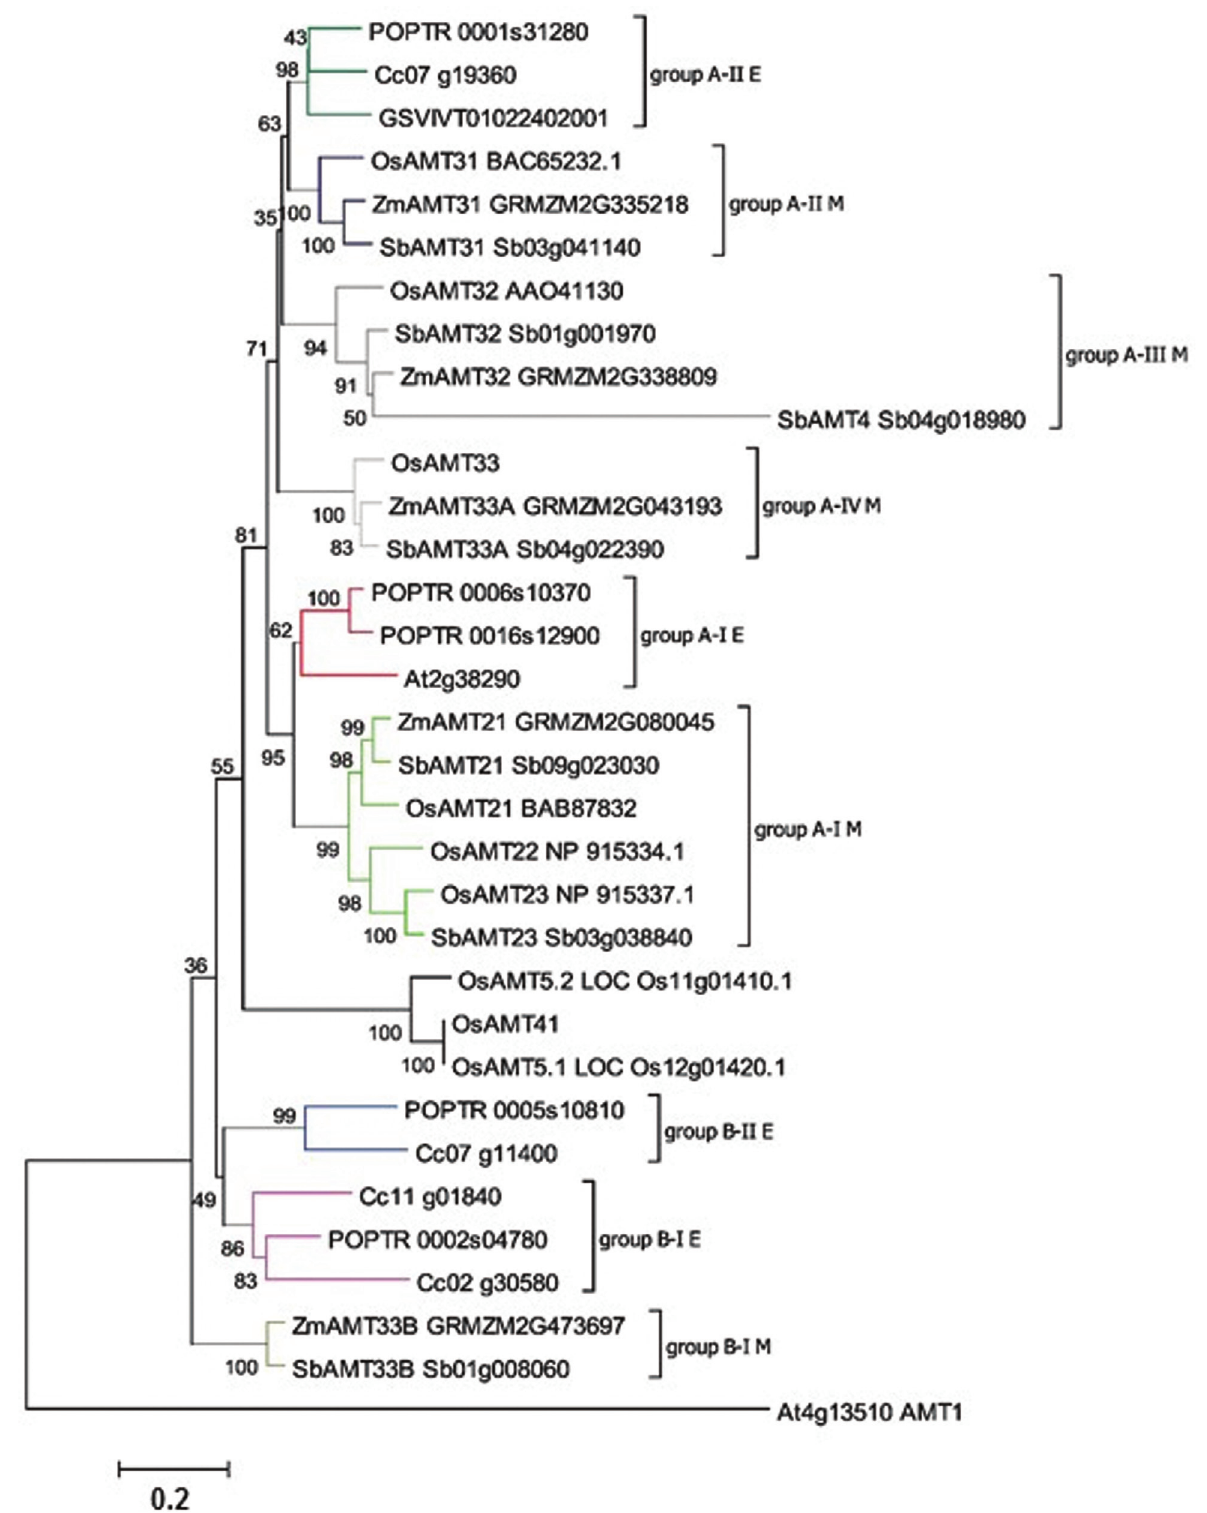
Figure2 -Neighborjoiningphylogeneticanalysisofthe AMT2 family.Thetreewasrootedusingan A.thalianaAMT1 geneasanoutgroup.Percentboot- strap values from 1,000 replicates are given. All C. canephora genes are placed in clades with > 50% of bootstrap support. Taxonomic groups are colored based on groups: dark green and red refer to group A eudicot sequences; dark blue, dark grey, light grey and light green represent monocot sequences in groupA-II;blueandpurpleillustratedicotsequencesingroupB,greyrepresentsgroupBmonocotsequences.Accessionnumbersareshown.Codeswere retrieved from the Coffee Genome Hub for C. canephora sequences and Phytozome for all other species. Phylogenetic groups were based in von Wittgenstein et al.